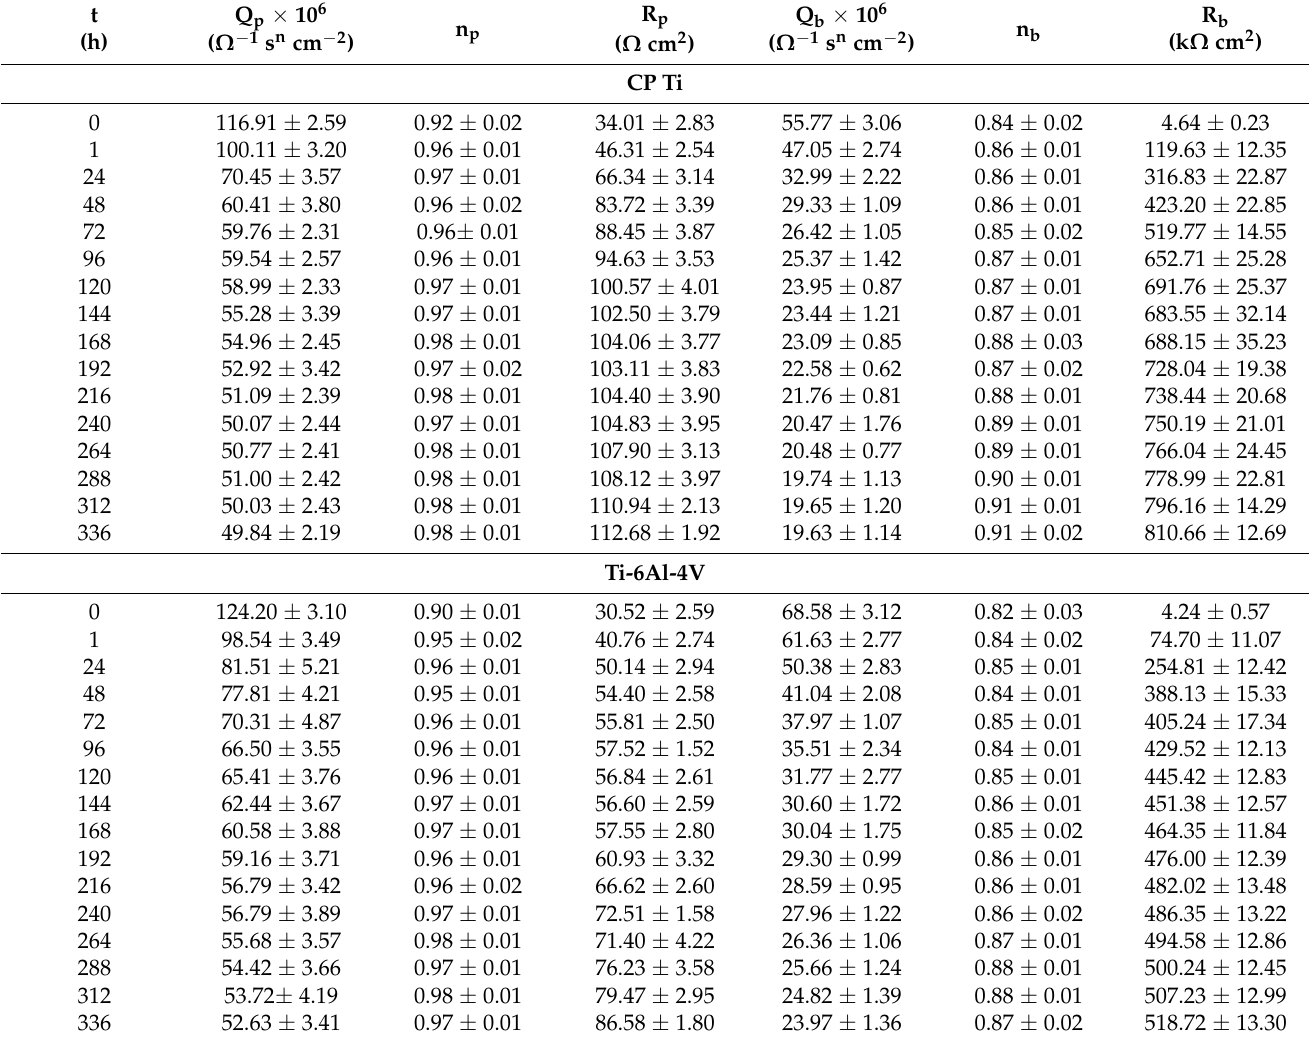
Figure 7. ( a ) Schematic representation of oxide layer on the metal surface, ( b ) equivalent circuit. Table 5. Electrical parameters of equivalent circuit obtained by fitting the experimental results of EIS for CP Ti and Ti-6Al-4V alloy in PBS solution at different stabilization times on E OC